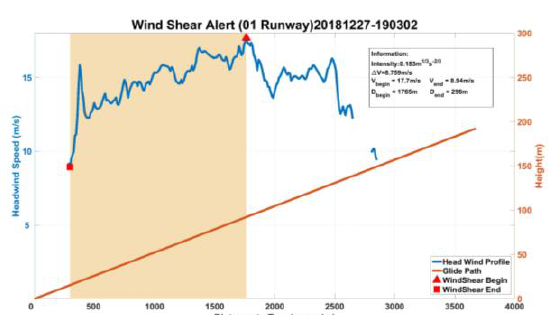
Fig.4. Glide path radial velocity of 01 runway on December 27, 2018.